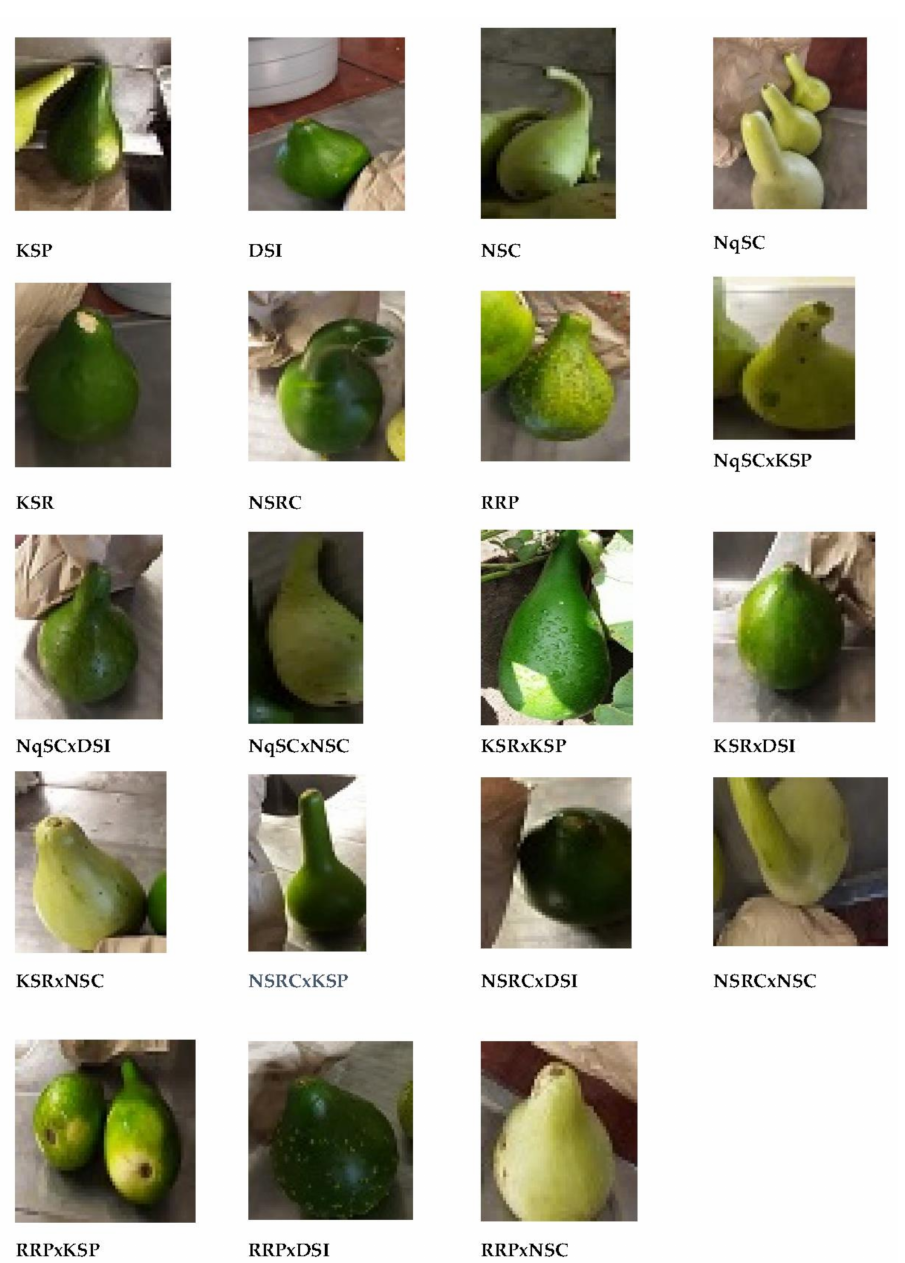
Figure 2. Diversity in fruit color, fruit shape, and fruit texture among Lagenaria siceraria genotypes. The dominant seed color amongst genotypes was brown exhibited by 15 genotypes (78.9%), while three genotypes (15.8%) displayed light brown color and one genotype (5.3%) had dark brown seed color (Table 2 and Figure 3). The recorded differences in the seed shape among genotypes were in the following descending order (number and percentage): ovate (10, 52.6%); oblong (8, 42.1%), and; obovate (1, 5.3%) shapes (Table 2 and Figure 3). All genotypes exhibited vigorous plants with a rapid ground cover habit, and the tendrils were produced by all genotypes. White flower color, large flower size, green stem color, and white fruit pulp color were observed in all genotypes. Seeds of all genotypes had lines and a rough texture. All genotypes showed a heart-shaped leaf. The tendril type was coiled and branched for all genotypes. There were five petals observed in all genotypes and staminate flowers were exhibited in the main vine, whereas the pistillate flowers were borne in the lateral